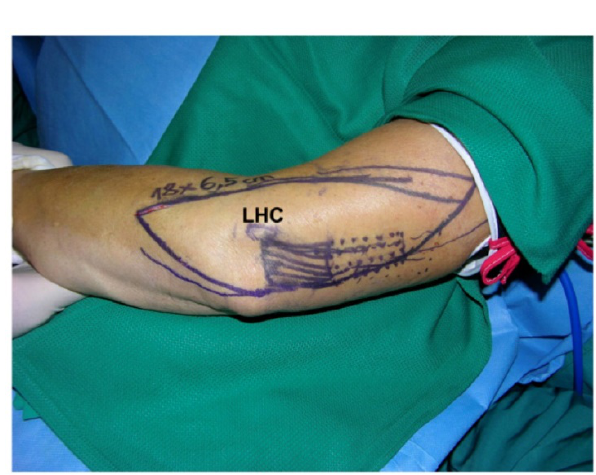
Figure 8: Free s-ELA: Markings to raise the flap with a triceps tendon (18 x 6.5 cm dimension) over the lateral humeral condyle (LHC) (Table 1: Patient No. 3; additional Figures 5, 7, 9, 18, 19).